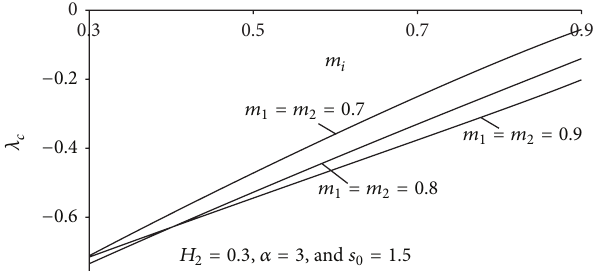
Figure 6: Variation of 𝜆 𝑐 with 𝑚 𝑖 at different values of 𝑚 1 = 𝑚 2 (other input parameters are fixed).